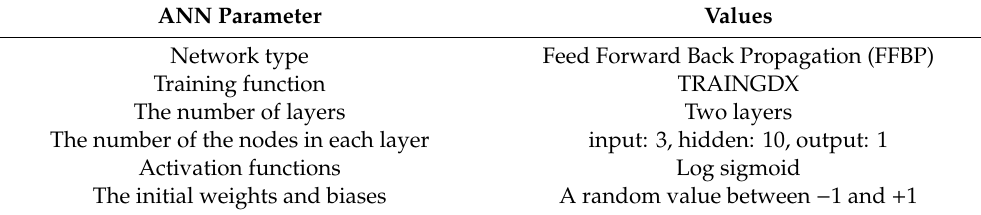
Table 2. The processing parameters of the training data.